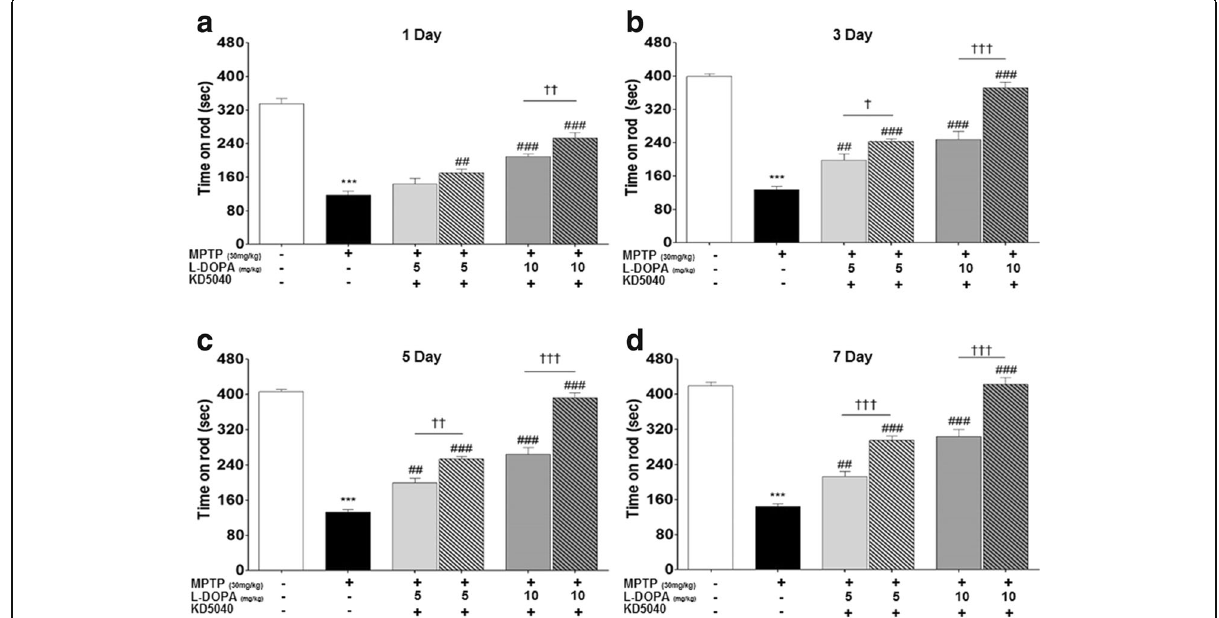
Fig. 2 Effects of combination treatment on days 2 ( a ), 4 ( b ), 6 ( c ), and 8 ( d ) after first treatment with KD5040 based on the rotarod test. The groups (LL and ML) exhibited dose-dependent increases in latency time, and the combination treatment resulted in synergistic increases. C: